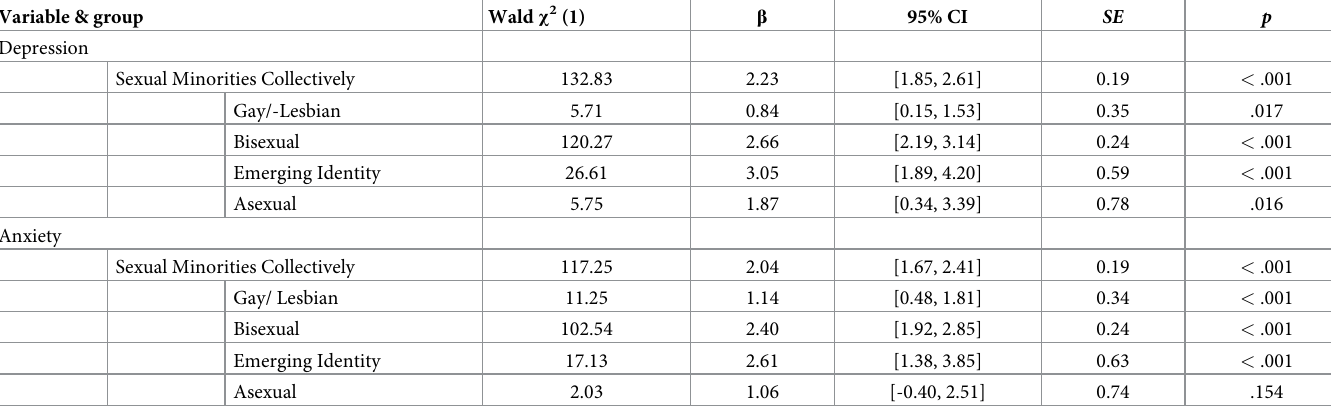
Table 3. Comparing sexual minorities to heterosexual individuals on anxiety and depression. Variable & group